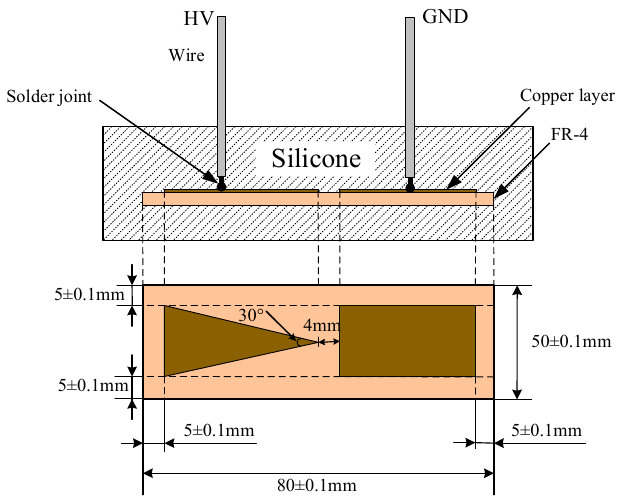
Figure 2. Encapsulation interface.